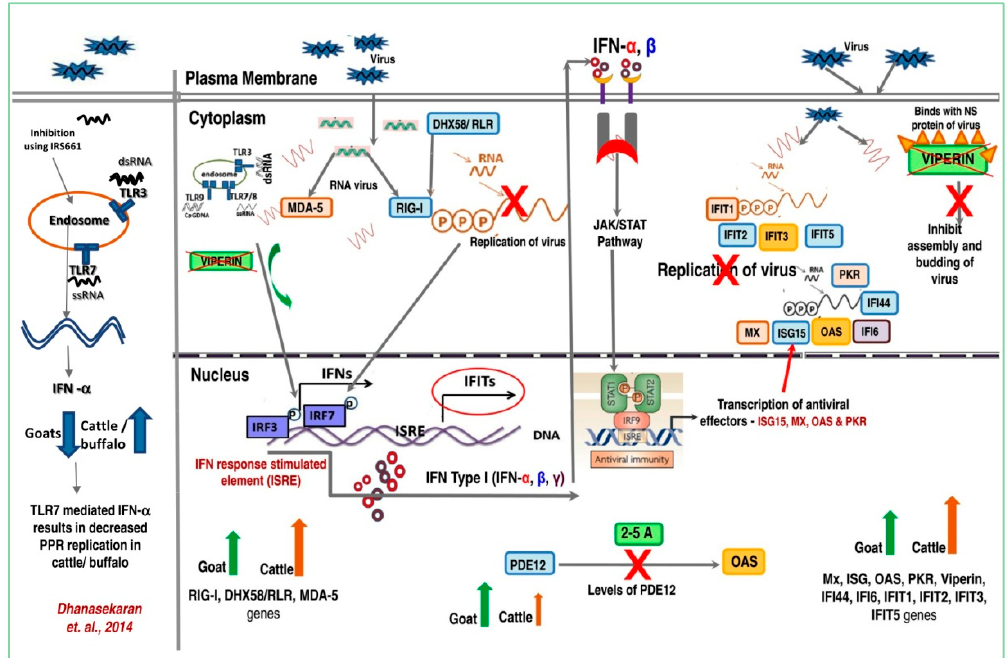
Figure 7. Postulated mechanism of disease resistance in cattle to PPRV—Schematic representation of roles of differentially expressed genes. The TLR7 mediated differential induction of RIG-I, DHX58, RLR and MDA5 contributes to the differential interferon levels which in turn modulate the viral replication across these two species. The increased levels of PDE12 might contribute to negative regulator of the OAS pathway in goats.